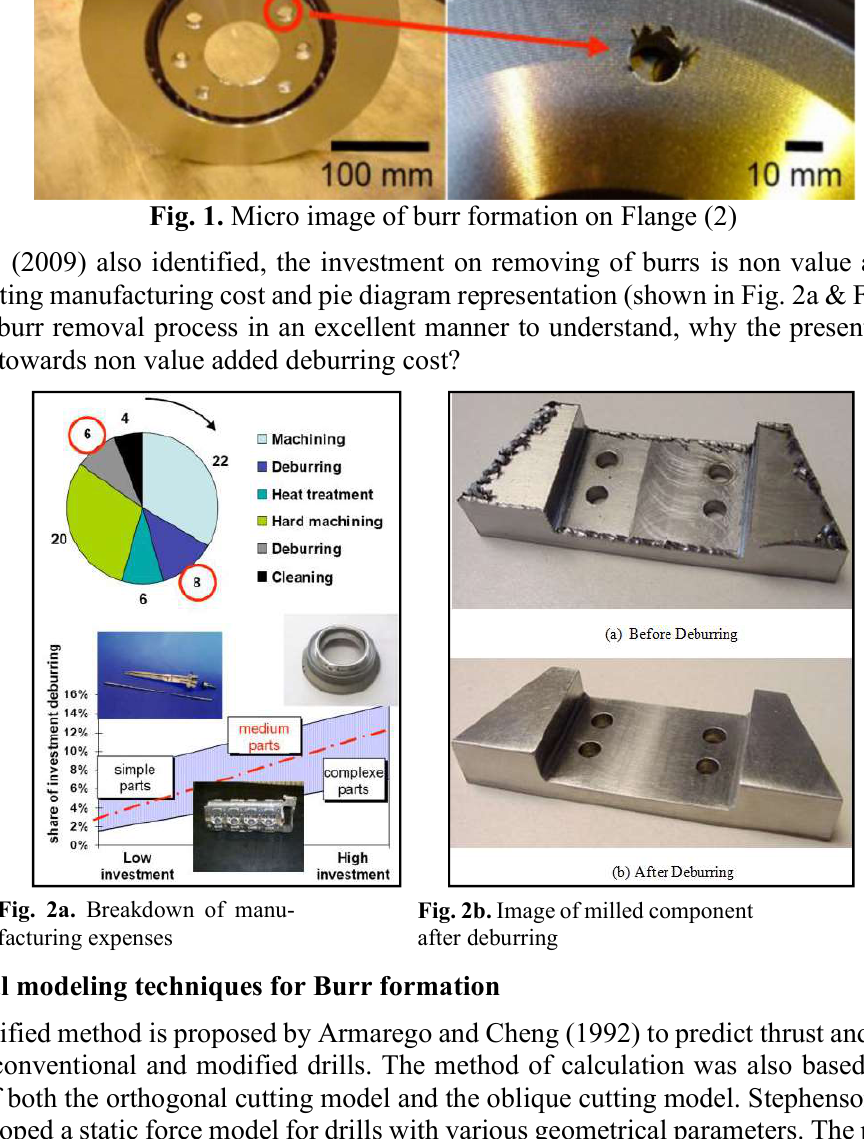
Fig. 2a. Breakdown of manu- facturing expenses